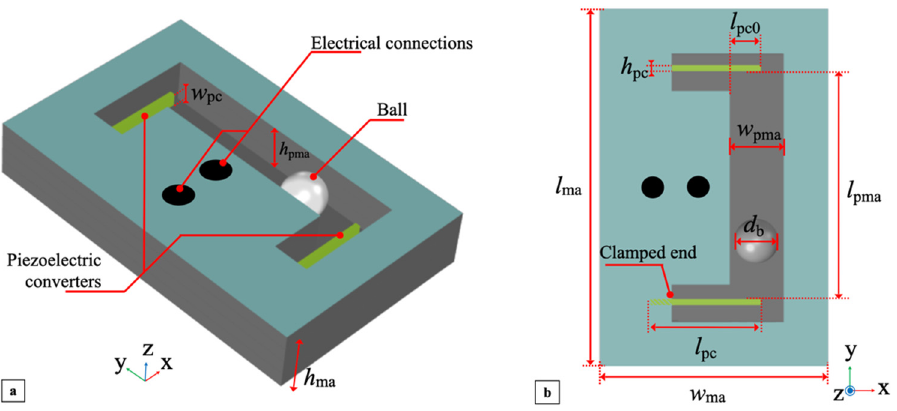
Figure 1. A 3D view ( a ) and top view ( b ) of the mono-axial multi-converter piezoelectric harvester.